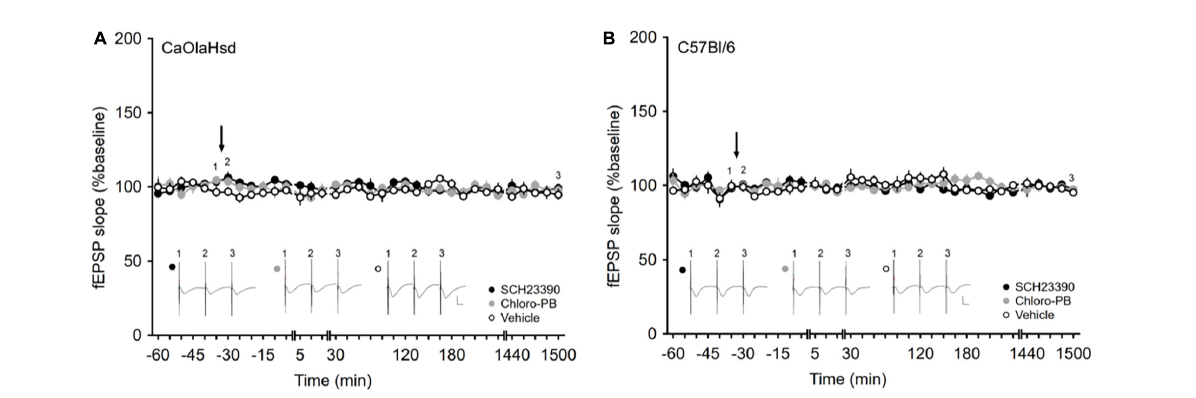
FIGURE2 Application of the D1/D5 receptor antagonist and agonist have no influence on basal synaptic plasticity. (A,B) Treatment with the D1/D5 receptor antagonist SCH23390 (7.5 µ g/ µ l, solid black circles) or the D1/D5 receptor agonist Chloro-PB (10.5 µ g/ µ l, solid gray circles) has no effect on basal synaptic transmission elicited by test-pulse stimulation compared to vehicle-injection (open circles) in (A) CaOlaHsd mice ( p = 0.24 and p = 0.69) and (B) C57Bl/6 mice ( p = 0.20 and p = 0.62). Black arrow depicts the time-point of injection. Inset shows analog examples of fEPSPs recorded at the time points indicated by the numbers in the graph. Line breaks indicate change in time-scale. Vertical scale bar corresponds to 2 mV and horizontal scale bar corresponds to 10 ms.